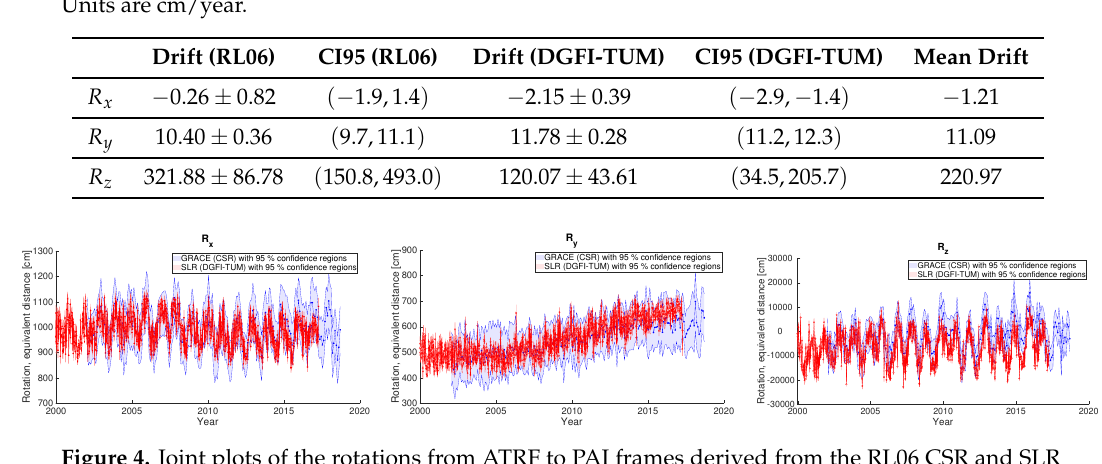
Table 4. Comparison of the linear trends of the rotations R x , R y , and R z obtained from the monthly CSR and weekly DGFI-TUM solutions. CI95 denotes the 95% confidence interval of the fit drift value. Units are cm/year.